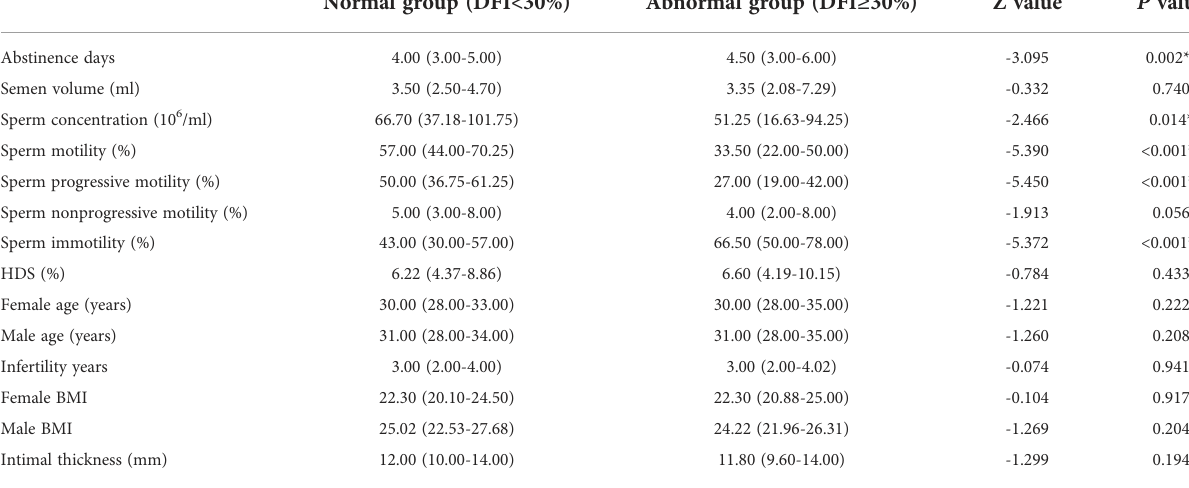
TABLE 2 Comparison of related parameters between the normal DFI group and abnormal DFI group in fresh embryo transfer cycles.